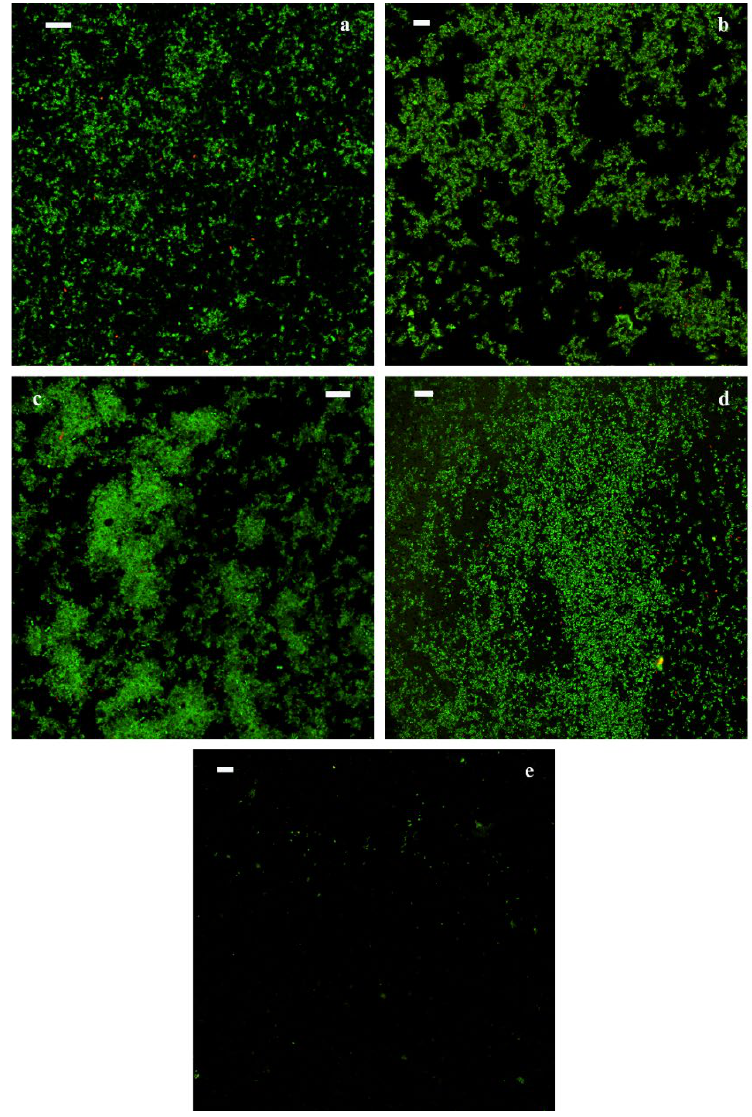
Figure 2. Confocal laser scanning microscope images of ice creams stained with LIVE/DEAD BacLight viability stain. ( a ) I1.WF; ( b ) I2.WF; ( c ) I3.WF; ( d ) I4.WF; and ( e ) CO.WF. Green fluorescence indicates live bacterial cells, red fluorescence indicates dead bacteria cells. All panels refer to theses without the addition of dietary fibers. Bar = 10 μm.